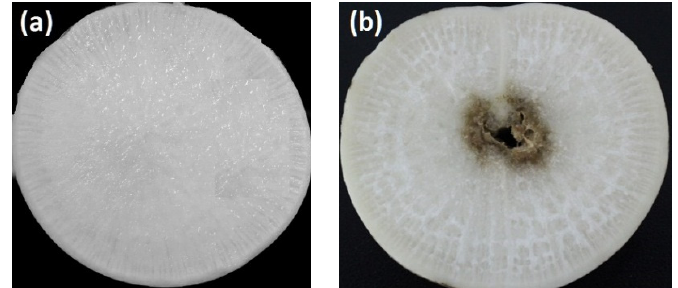
Figure 1. Normal ( a ); and defective ( b ) (with black heart) slices of radishes.